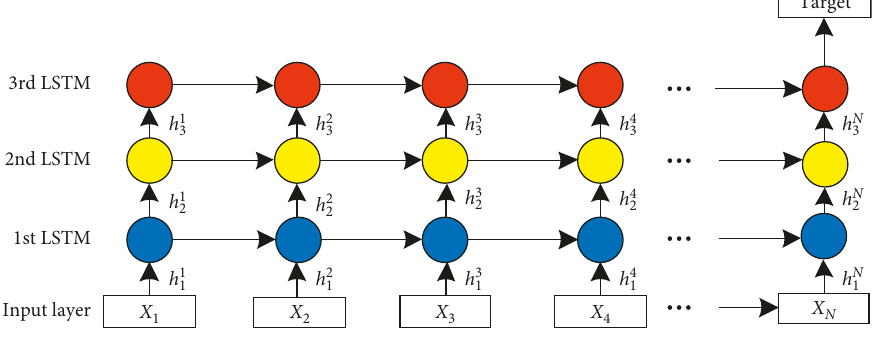
Figure 2: The hierarchical structure of